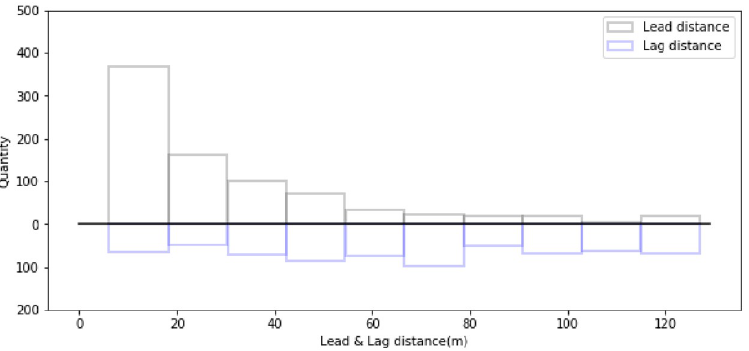
Fig 8. Statistical histogram of the lead and lag